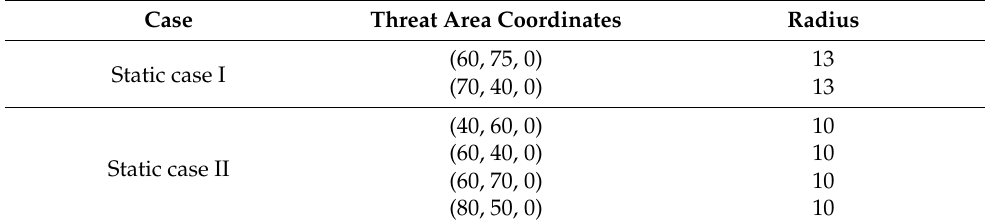
Table 2. The threat information of a static